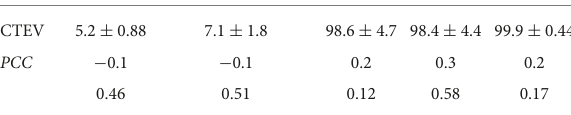
TABLE 5 Correlation between CTEV severity, number of casts, and